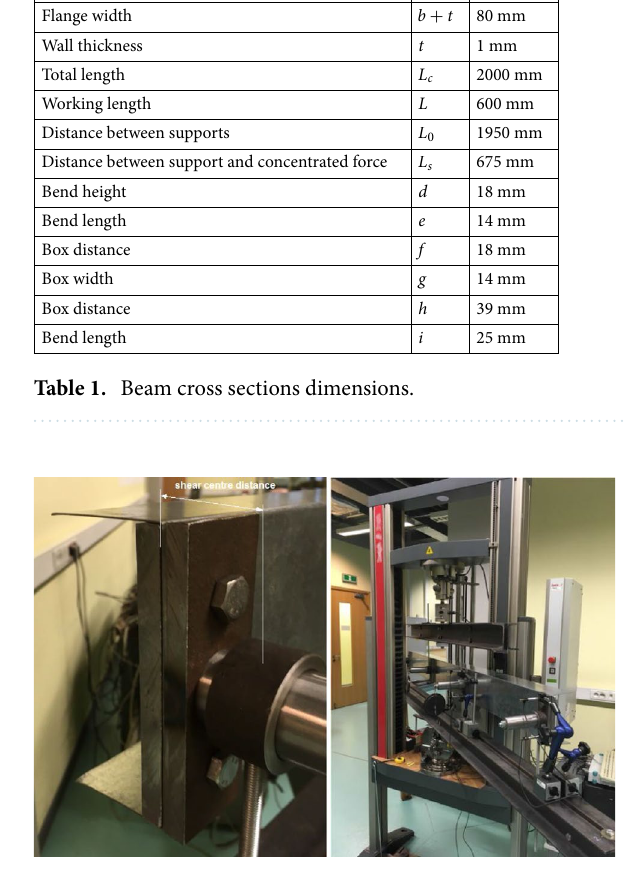
Figure 1. Web stiff steel plates and hinge which allow set and load the beam in shear centre.